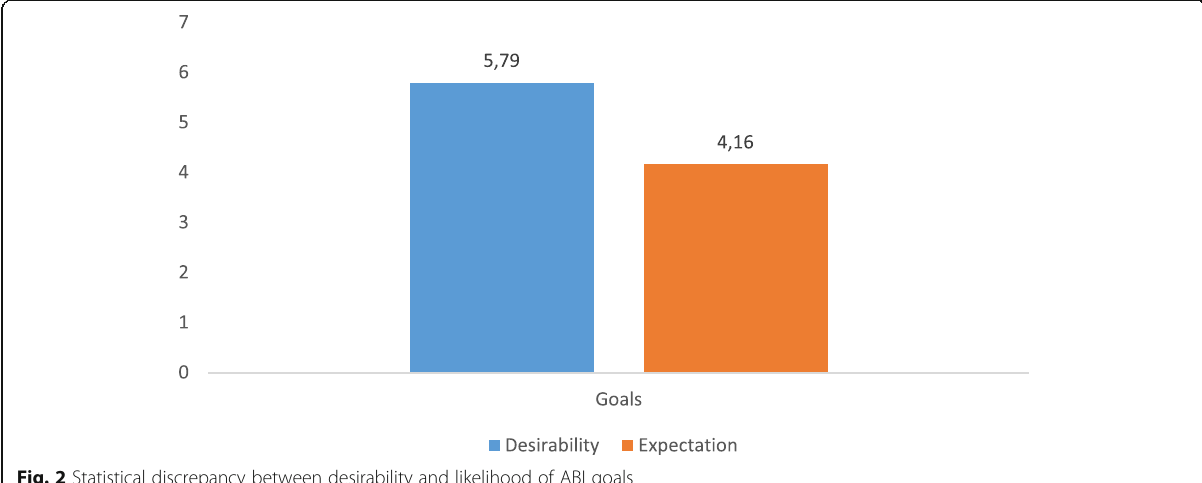
Fig. 2 Statistical discrepancy between desirability and likelihood of ABI goals